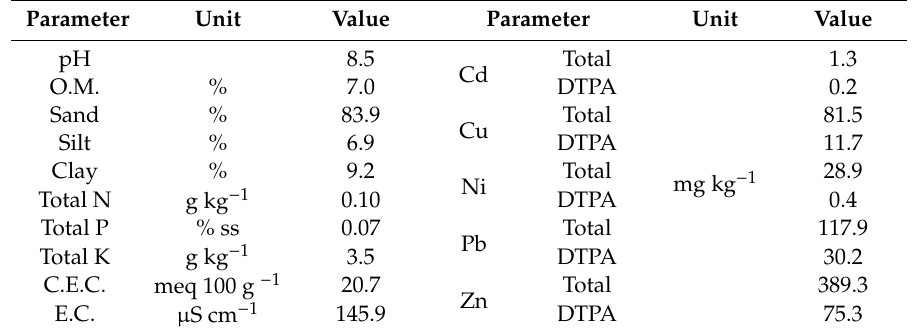
Table 1. Physical and chemical properties of the soil of the experimental site at the beginning of the trial. Parameter Unit Value Parameter Unit Value pH